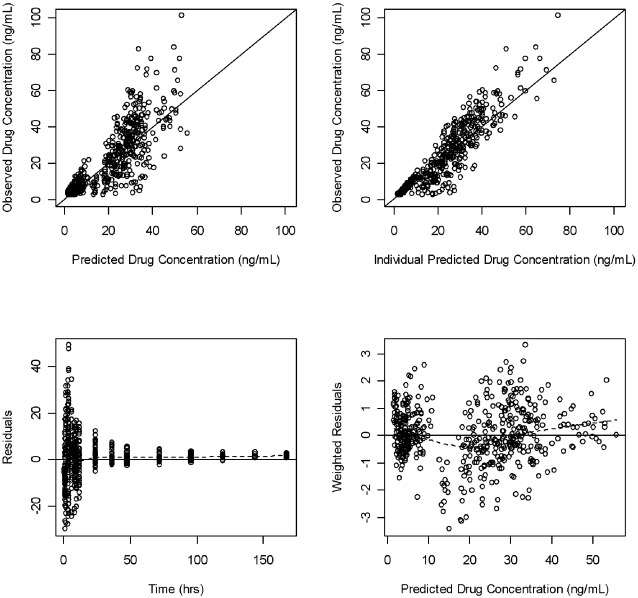
Goodness-of-fit plots for the final population mixture model.Observed versus predicted and individual predicted plasma ivermectin levels. The solid line represents the line of identity (top panels). Residual versus predicted plasma ivermectin levels and weighted residual versus time, (bottom panels).